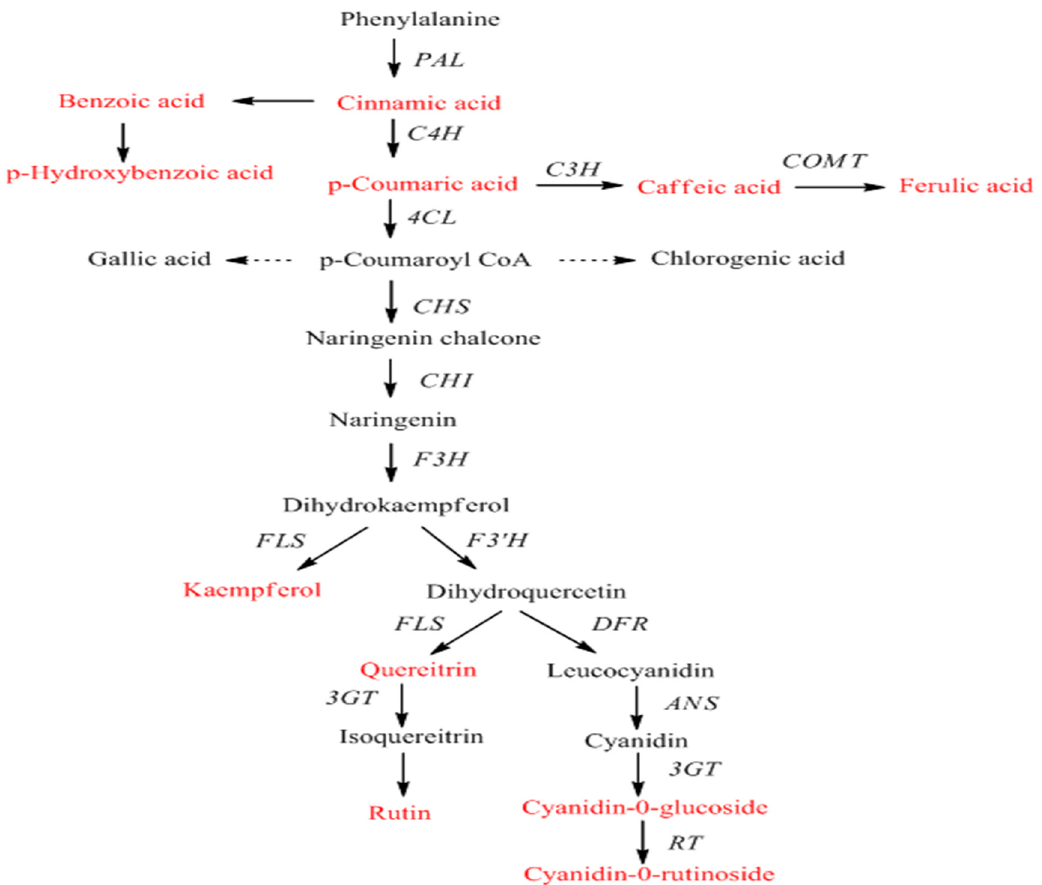
Figure 1. Schematic representation of flavonoid biosynthesis in tartary buckwheat. PAL, phenylalanine ammonium lyase; C4H, cinnamic acid 4-hydroxylase; 4CL, 4-coumarate-CoA ligase; CHS, chalcone synthase; CHI, chalcone isomerase; F3H, flavanone-3-hydroxylase; F3 ′ H, flavonoid-3 ′ - hydroxylase; FLS, flavonol synthase; DFR, dihydroflavonol reductase; ANS, anthocyanin synthase; 3GT, flavonoid 3-O-glucosyltransferase; and RT, 3-Orhamnosyltransferase. Red colored words indicate that the compounds were detected in this study.